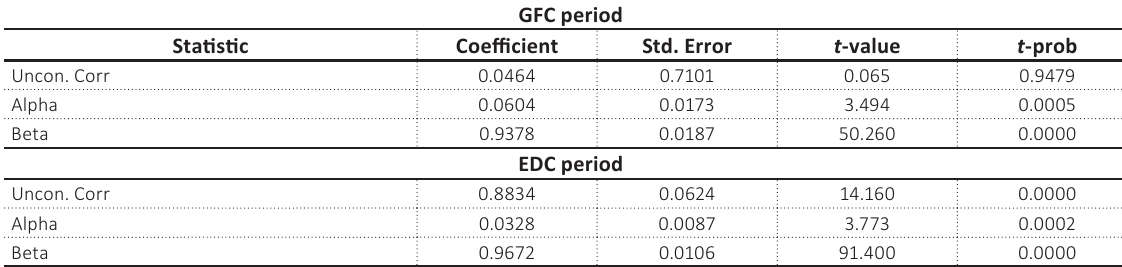
Table 3. Dynamic conditional correlations (Greece – Cyprus)